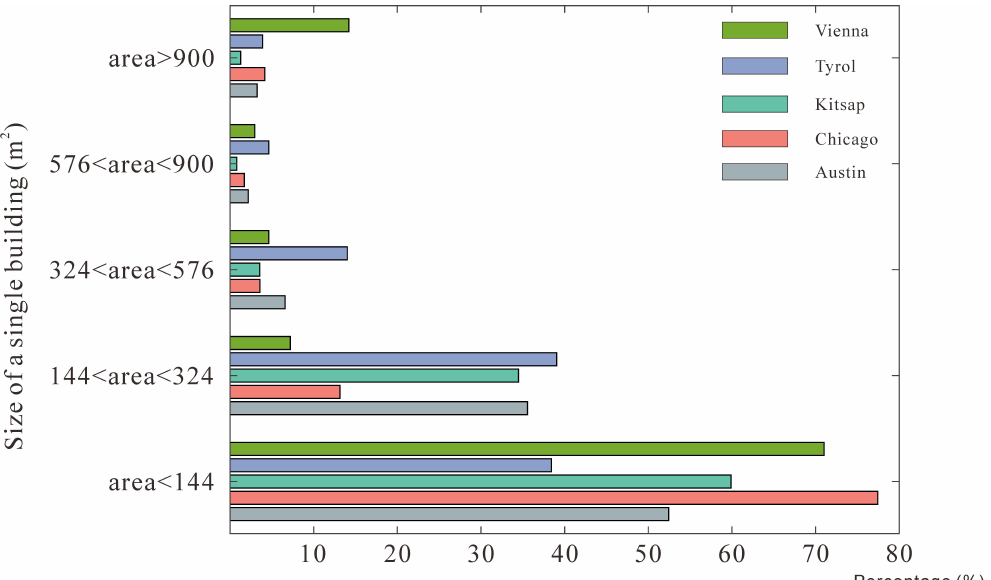
Figure 7. Statistical results of the single building size in the INRIA building dataset, including five cities, e.g., Vienna, Tyrol, Kitsap, Chicago, and